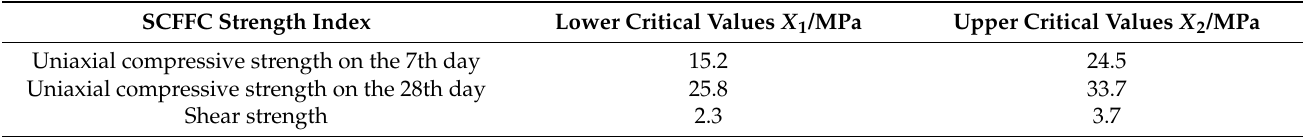
Table 4. The upper and lower critical values of SCFFC strength index.